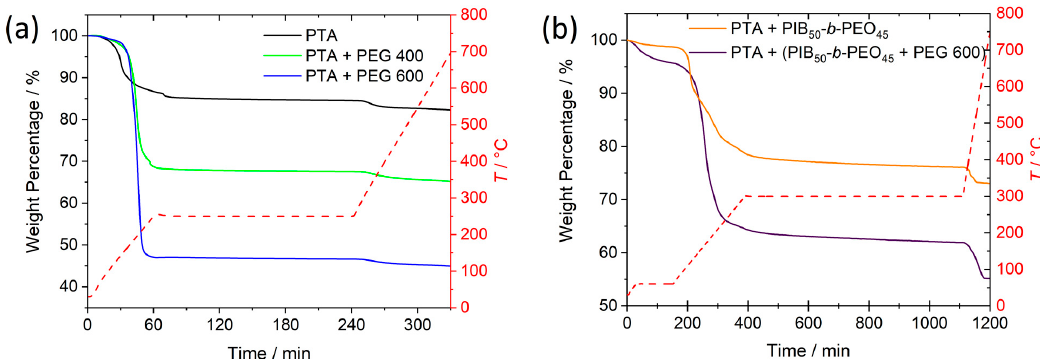
Figure 3. TG curves of the dried peroxotungstic acid precursor ( a ) without PEG (black), with PEG 400 (green), with PEG 600 (blue) and ( b ) with PIB 50 - b -PEO 45 (orange) and PIB 50 - b -PEO 45 + PEG 600 (purple). The dashed red lines show the temperature profile.